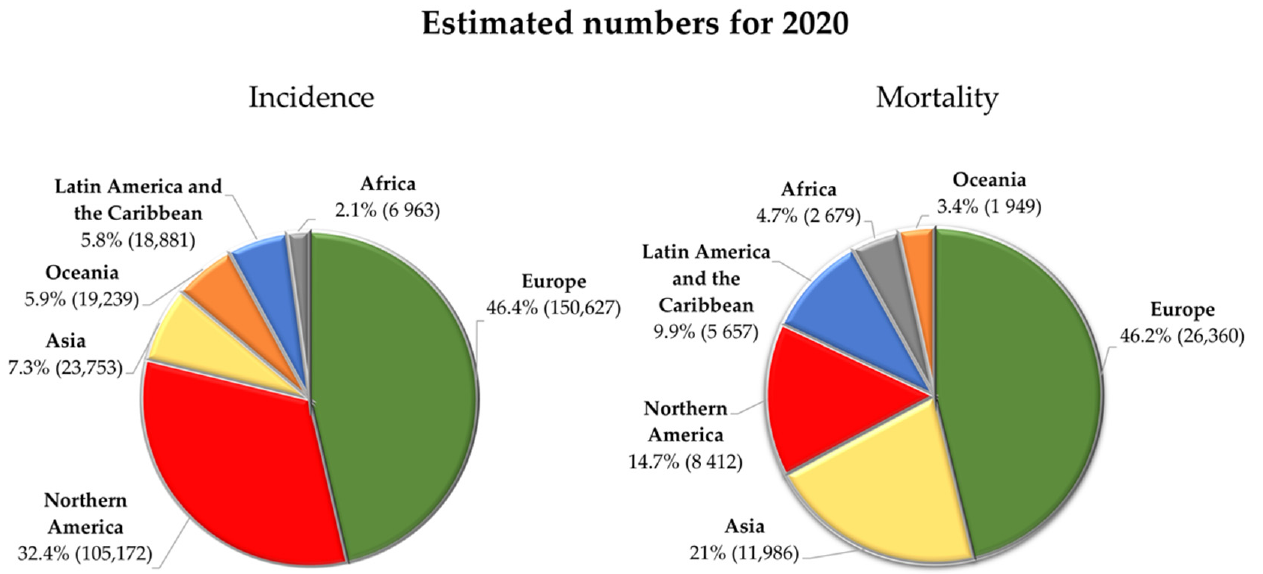
Figure 2. Estimated number of new skin melanoma cases and deaths worldwide in 2020 for both sexes and all ages. Data adapted from the Global Cancer Observatory by IARC [46,48].